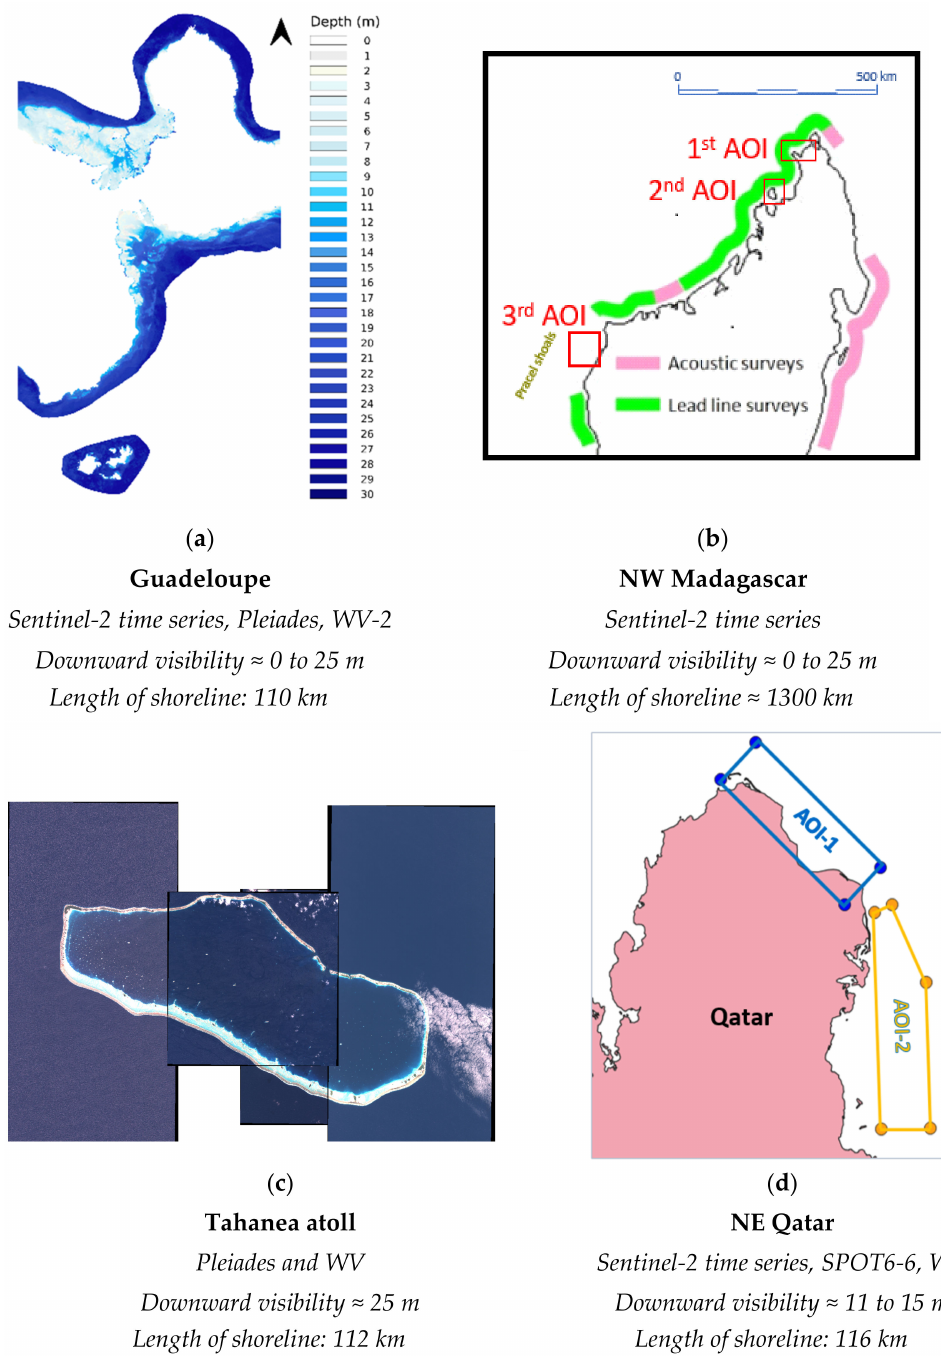
Figure 9. Four test zones and four satellite constellations to prove the new concept. ( a ) West Indies first exploration, ( b ) Madagascar, ( c ) French Polynesia, ( d )